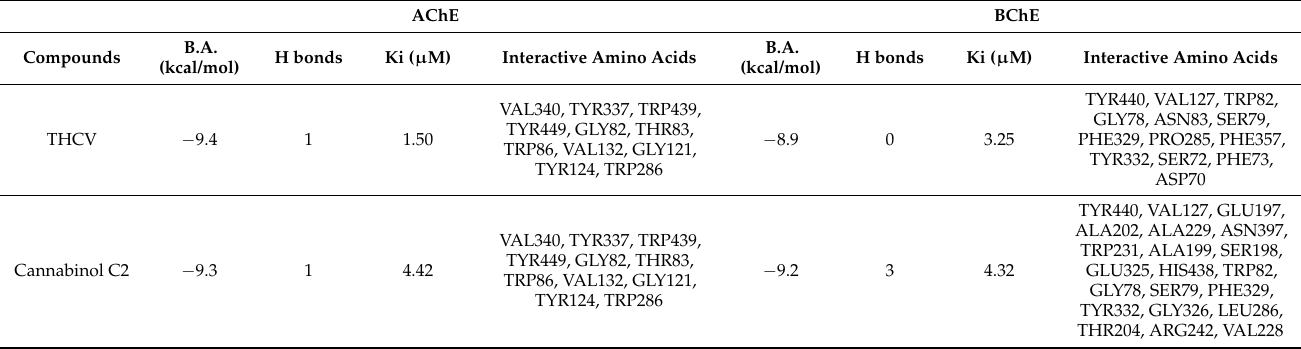
Table 3. Comparison of different docking parameters between three selected CBD analogues with AChE and BChE with reference